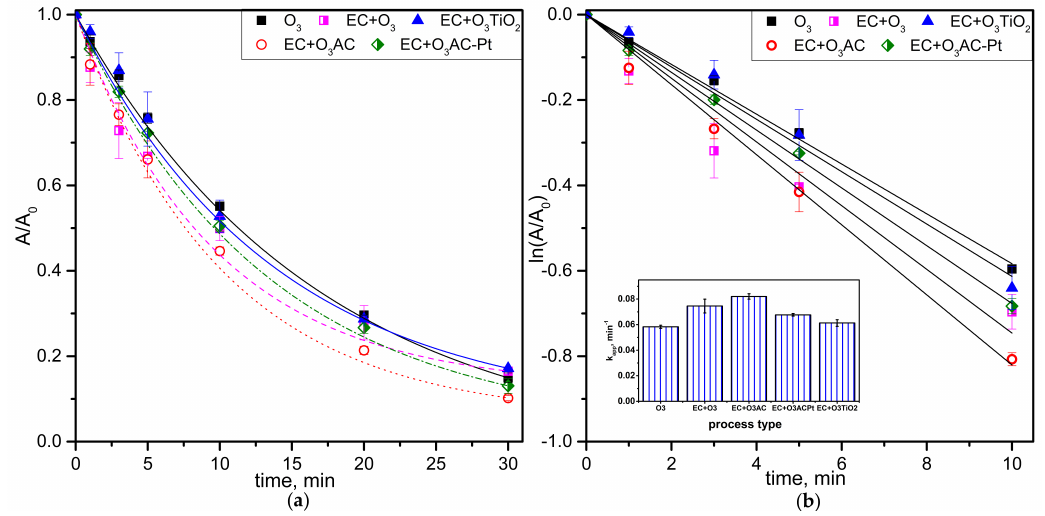
Figure 2. The electrocoagulation (EC) pretreated industrial wastewater during ozonation and catalytic ozonation using three types of catalysts ( a ) and pseudo-first-order rate of color removal ( b